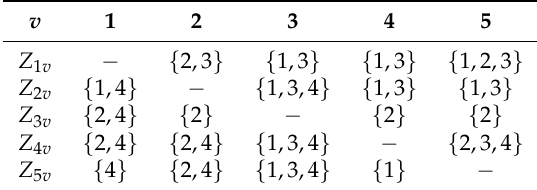
Table 13. Tabular representation of 3HF discordance